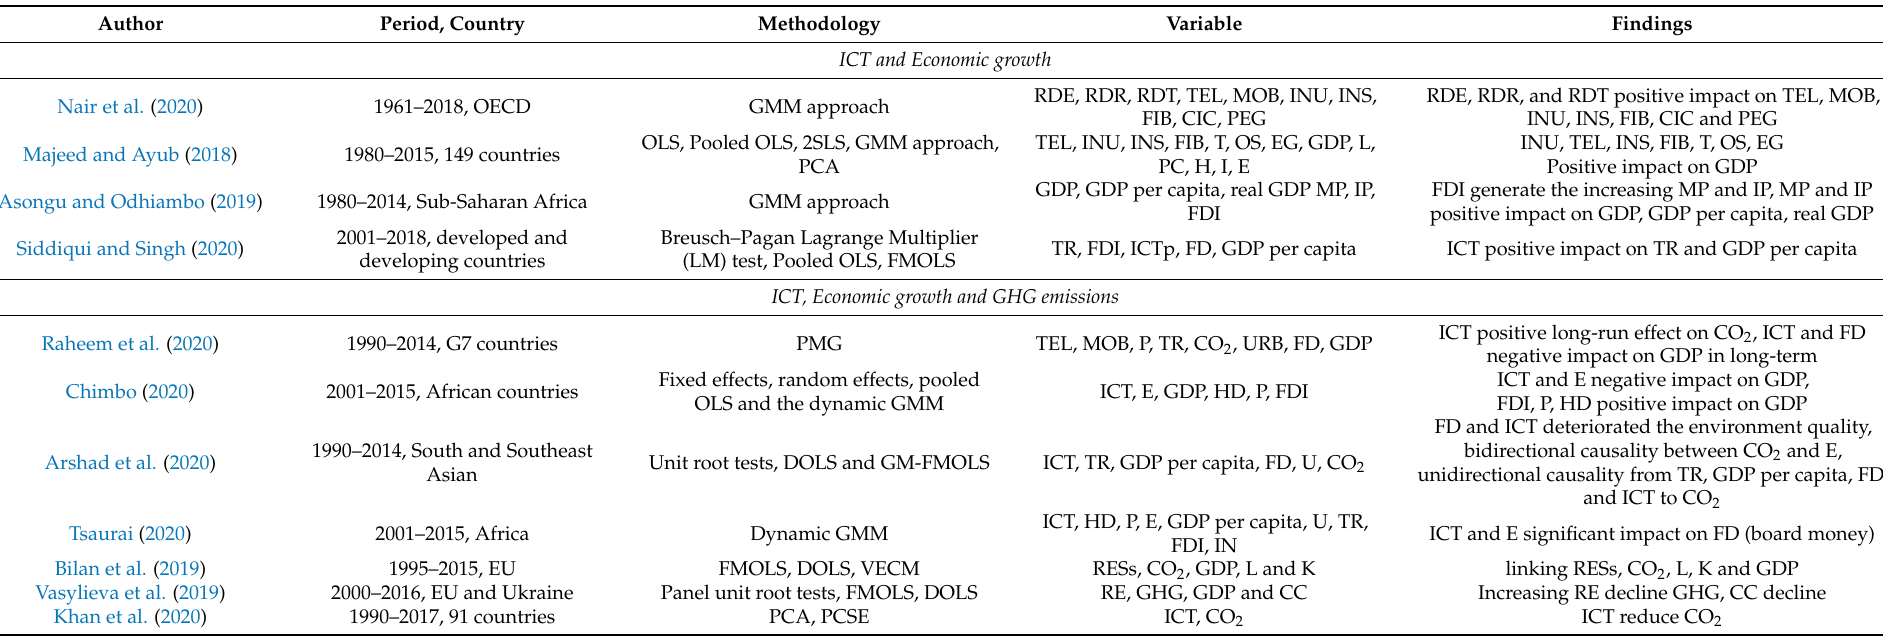
Table 1. The Approaches to Estimating the Link among ICT, Economic Growth and GHG Emissions (Source: developed by the